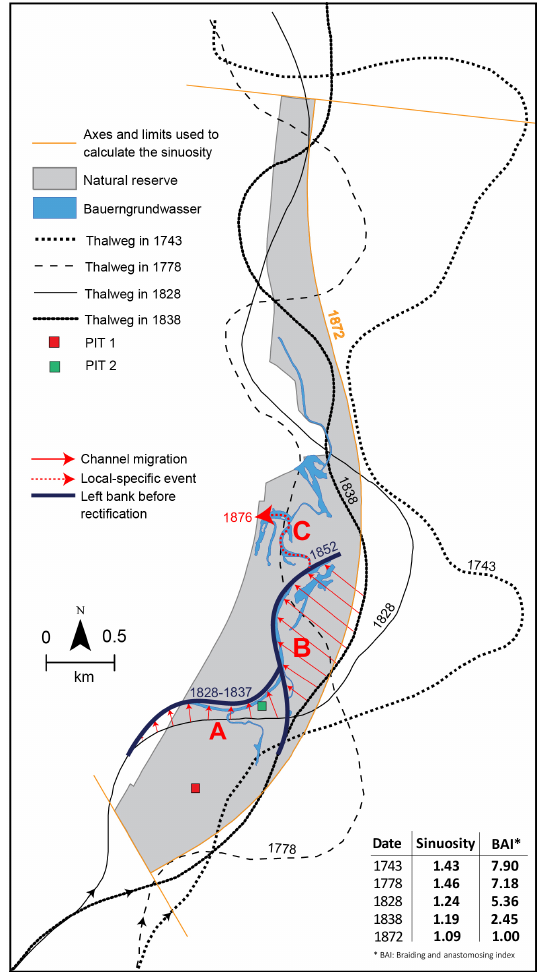
Figure 9. Rhine thalweg evolution from 1743 to the end of the cor- rection works in 1876. (A) Area of lateral channel mobility during the 1828–1837 period. (B) Area of lateral channel mobility during the 1851–1852 flood. (C) Area impacted by the 1876 flood. BAI is a Braiding and Anastomosing Index which corresponds to the mean number of these two types of channels (channels showing stagnant water have been